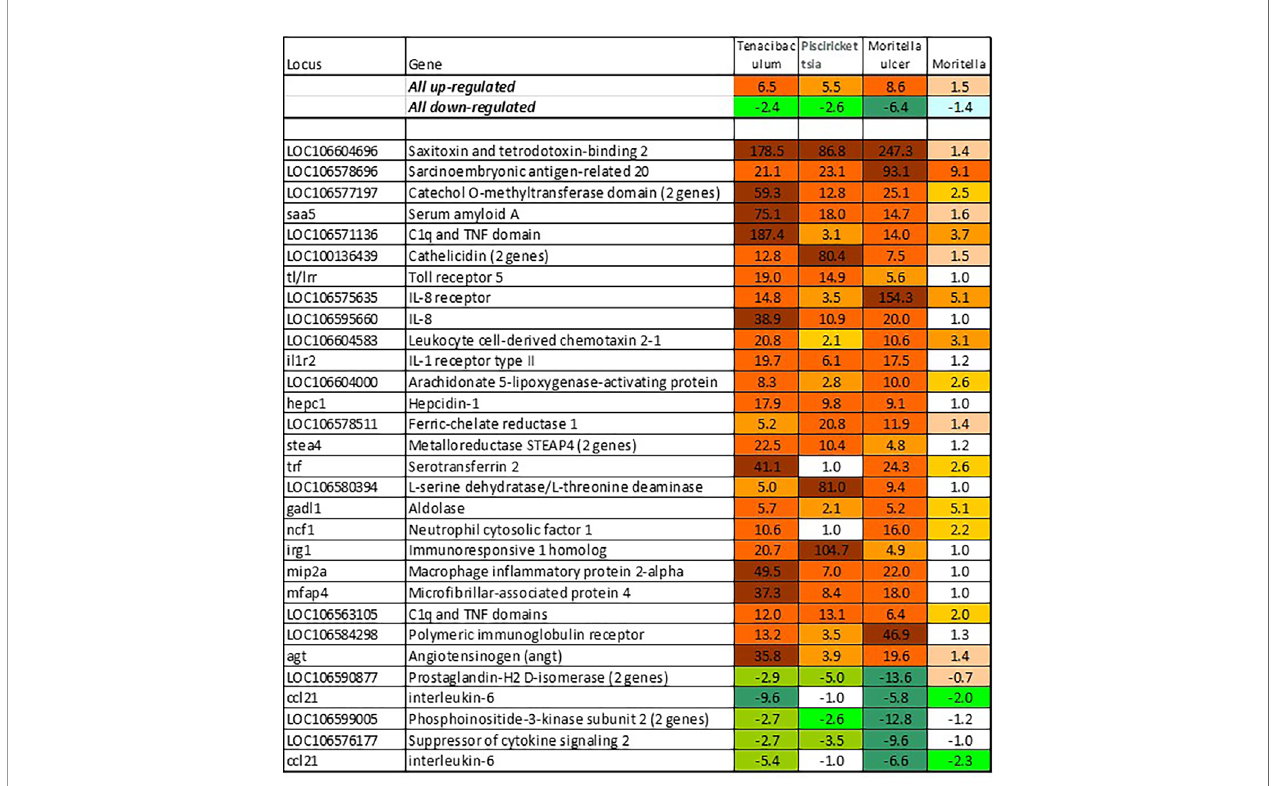
FIGURE 4 | Responses to pathogenic bacteria: genes ranked by the expression changes with respect to uninfected control. Information on tissues, cells and time-points is in Table 1 . Responses to T. fi nnmarkense and M. viscosa in whole skin and skin layers were averaged, ulcer is presented